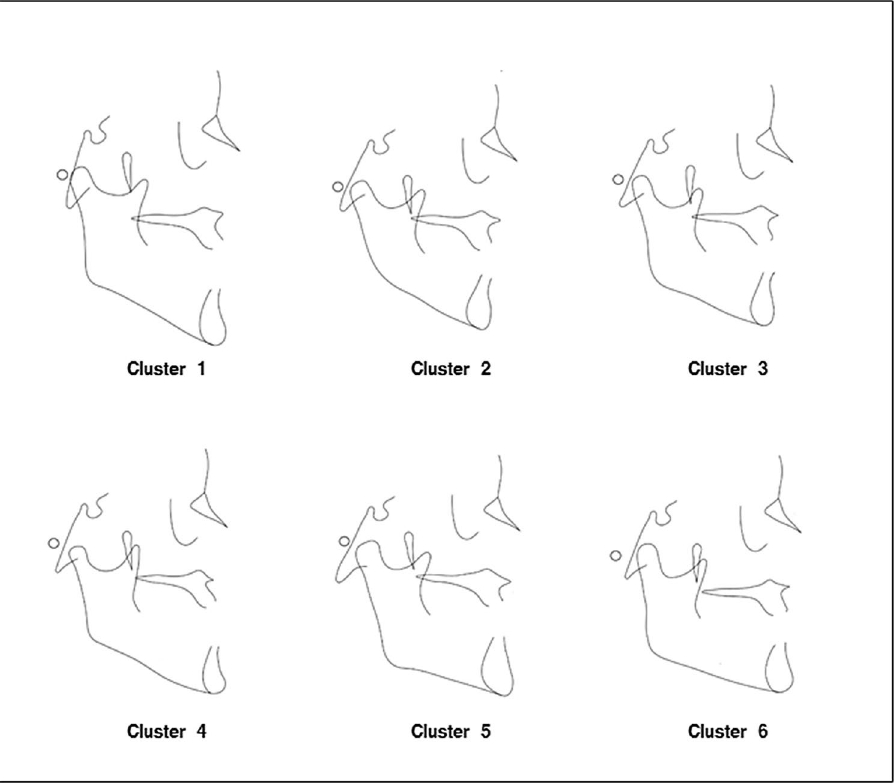
Figure 3. Cluster representation. Cephalometric tracings of the means of each cluster as explained in the